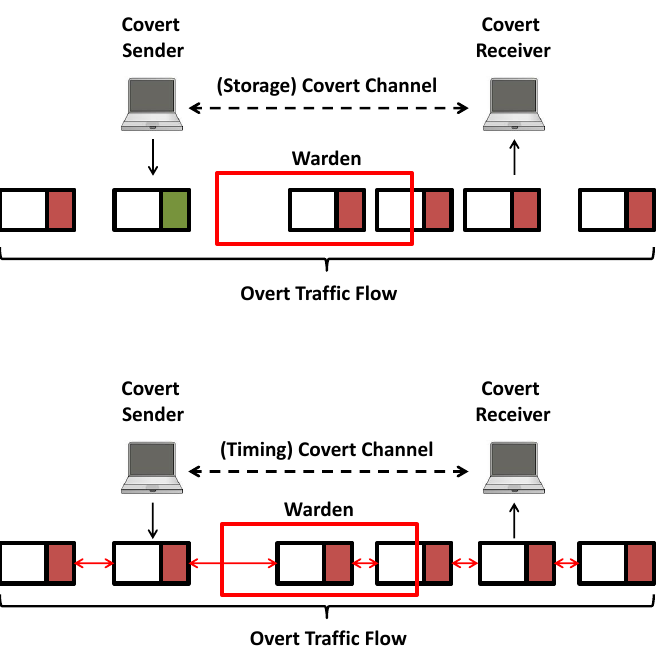
Figure 1. Reference scenario for the usage of network covert channels and their